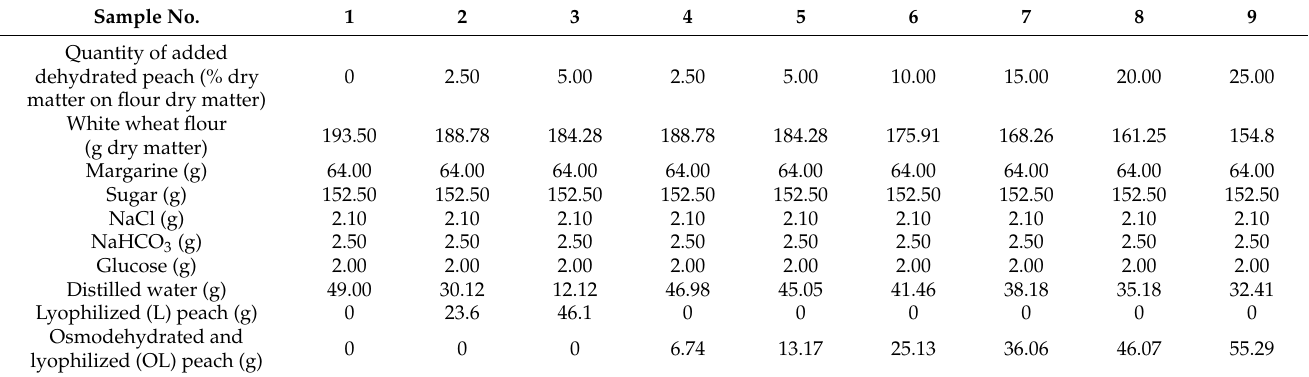
Table 1. Experimental plan and formulation for cookie samples with and without the addition of lyophilized and osmodehydrated and lyophilized